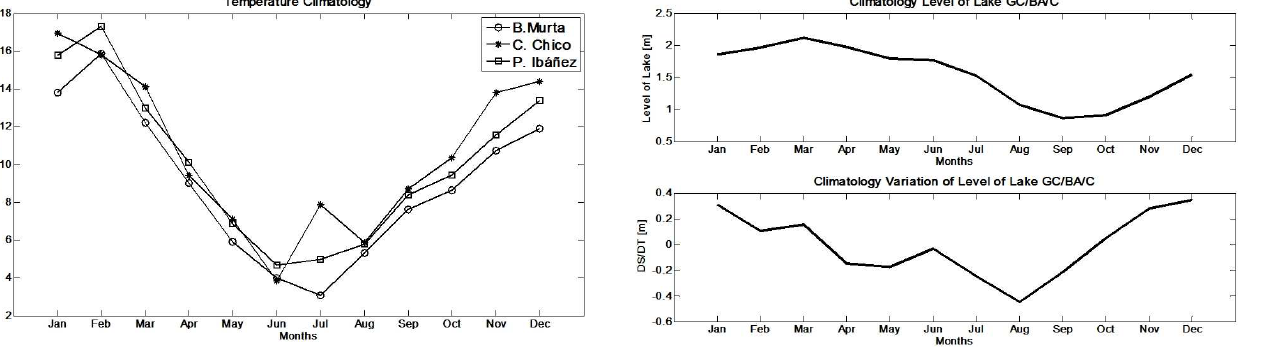
Fig. 4. In situ Lake Level associated variability. The upper panel shows monthly mean lake level. The lower panel the monthly mean lake level variation.